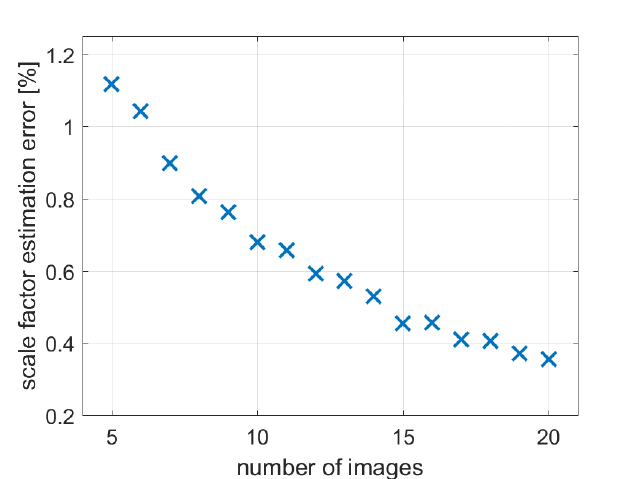
Figure 5. Scale factor estimation error varying the number of images randomly taken from the available